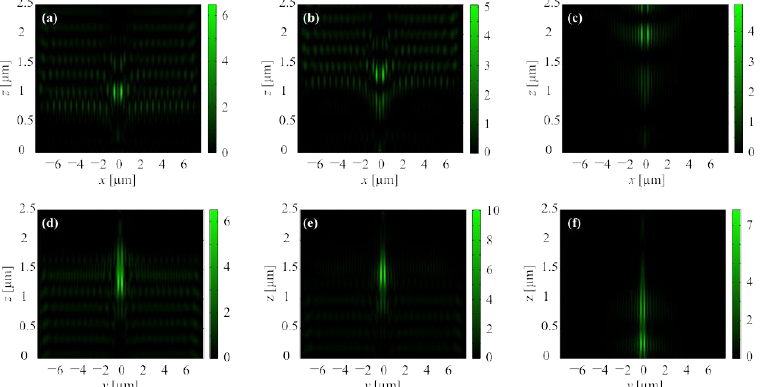
Figure 11. The instantaneous longitudinal of the intensity of the second-order CVB focused by quartz BZP pattern in XZ-plane ( a – c ) and YZ-plane ( d – f ) at the time moment of 120.08 fs ( a , d ), 134.09 fs ( b , e ), and 208.14 fs ( c , f ).